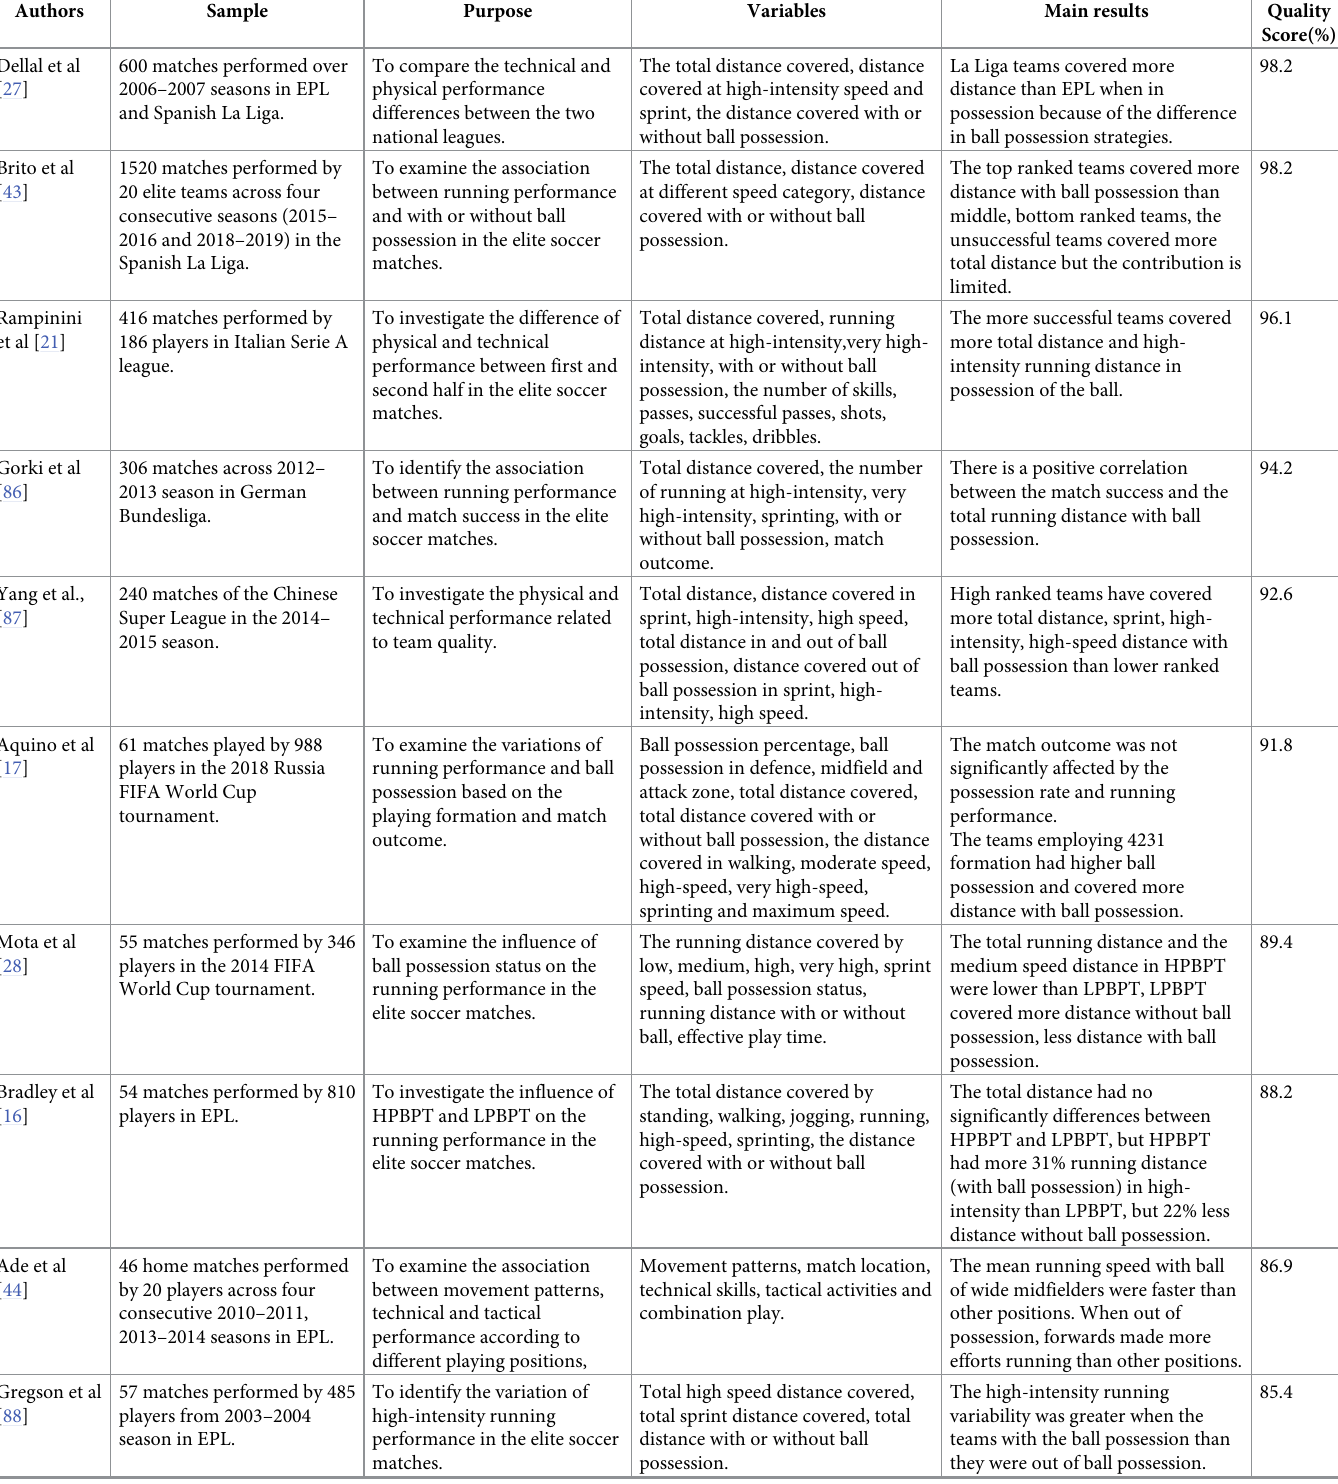
Table 5. Studies of the running performance with possession of the